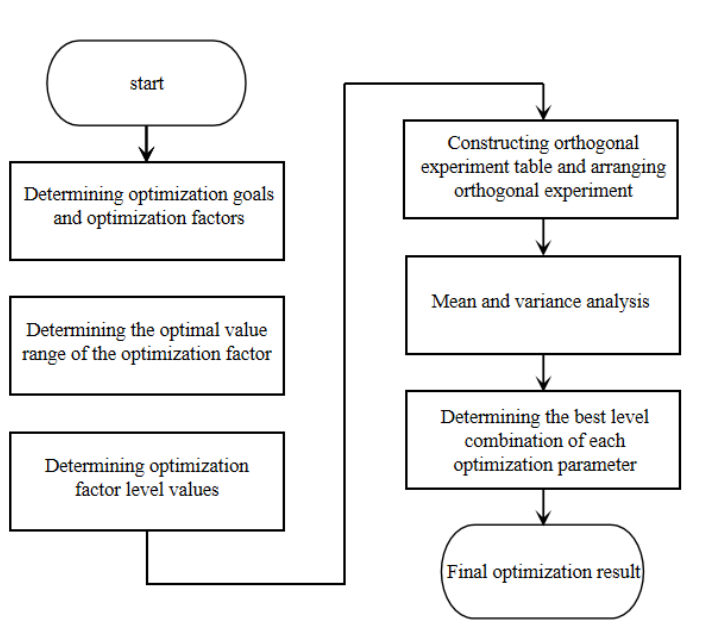
Figure 14. Flow chart of optimization design of Taguchi method.